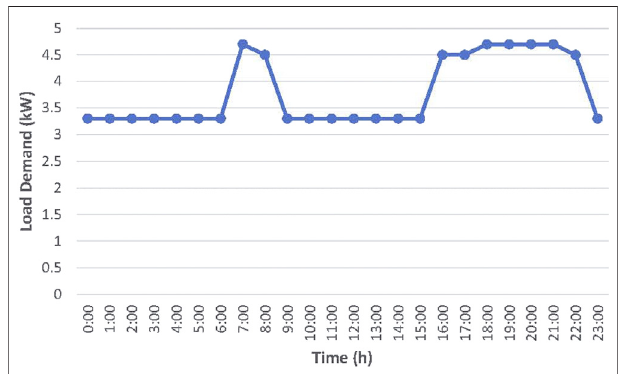
FIGURE 5 | Daily load demand of a household.